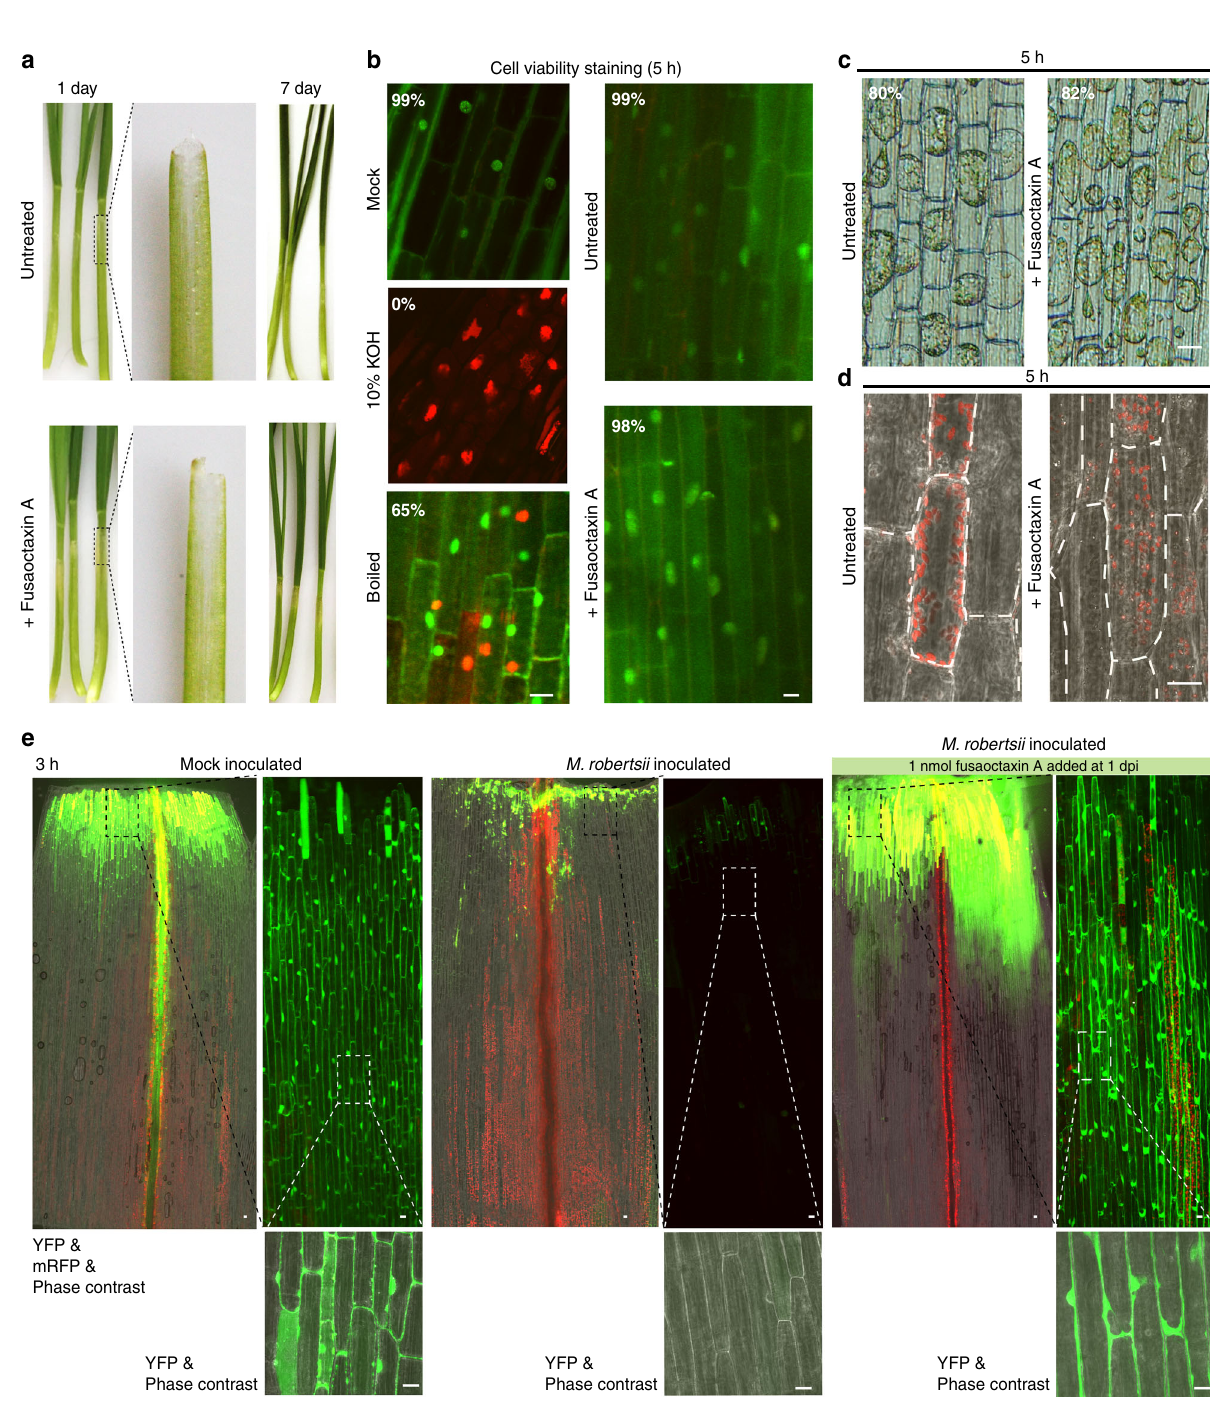
Fig. 8 Fusaoctaxin A changes chloroplast subcellular localization and terminates the plasmodesmal closure response. a Wheat seedlings with or without the octapeptide applied at the top edge of the coleoptile. The middle panel shows the coleoptiles that were gently detached from the seedling immediately before imaging. b Viability of wheat coleoptile cells with various treatment assayed by Acridine orange/ethidium bromide (AO/EB) staining. Boiled: the coleoptile treated by 95 °C water for 5 min. The average percentage of live cell (green signals from AO staining in nuclei) numbers divided by the sum of live and dead cells (orange signals from EB staining in nuclei) in each sample is labeled in the image. c Representative micrographs comparing the cell plasmolysis ability in wheat coleoptile with or without octapeptide treatment for 5 h. The average percentage of cells that exhibited plasmolysis in each sample is labeled in the image. d Representative confocal micrographs comparing wheat coleoptile cells with or without the octapeptide treatment for 5 h. A single plane of RFP confocal images is overlaid with the phase contrast light fi eld. Red signals are auto fl uorescence from chlorophyll. Broken white lines mark the margins of individual cells. e Drop-ANd-See assay of wheat coleoptiles showing the plasmodesmal permeability differences after fusaoctaxin A treatment for 3 h. Three-day-old wheat seedlings were mock-inoculated (left) or inoculated with Metarhizium robertsii . White scale bar = 20 μ